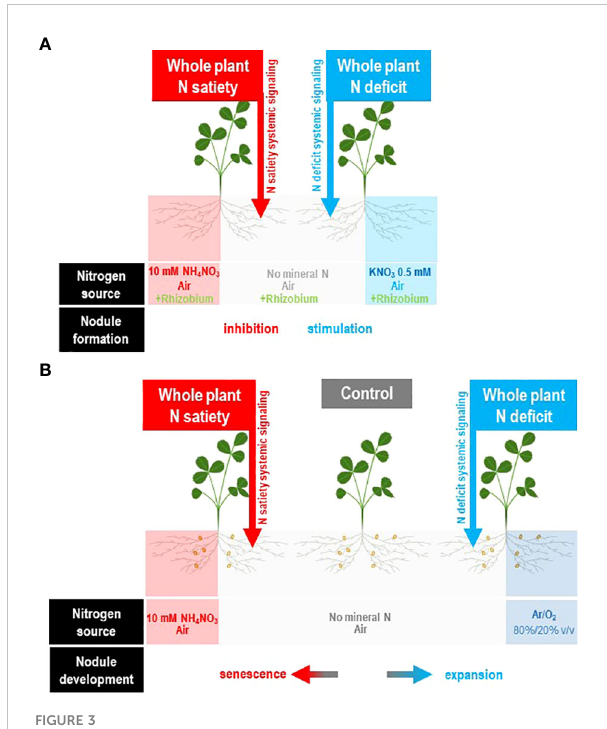
FIGURE 3 Split-root systems to characterize the control of nitrogen- fi xing symbiosis by systemic N signaling of the plant N demand. The experimental systems are described in the original studies of Ruffel et al. (2008); Jeudy et al. (2010); Laguerre et al. (2012); Lambert et al. (2020), and Pervent et al. (2021). M. truncatula plants are cultivated hydroponically. The root system of each plant is separated into two compartments. Each compartment receives speci fi c N supplies: either low level of mineral N supply (0.5 mM KNO 3 ), high level of mineral N supply, air (N 2 /O 2 80/20 v/v), or no gaseous N supply (Ar/O 2 80/20 v/v). At the beginning of the experiment, a contrasted N supply is applied to a half-root system. The N treatment modi fi es the whole plant N status and the whole plant N demand without affecting the environment and the untreated half- root system. Response of the untreated roots to this treatment results necessarily from systemic signaling originated from the rest of plant to these roots. (A) Split root systems used to study the control of nodule formation by plant N demand (Pervent et al., 2021). Non symbiotic plants are used. Contrasted mineral N supply applied to half-root systems may either fully satisfy the plant N demand (N satiety) or results in plant N limitation (N de fi cit). The response to inoculation by rhizobium in untreated roots strongly relies on the level of N supply of the plant revealing the strong systemic control of nodule formation by systemic signaling of the plant N demand. (B) Split root systems used to study the control of mature nodules by the plant N demand (Jeudy et al., 2010; Laguerre et al., 2012; Lambert et al., 2020). Symbiotic plants supplied with air as a unique N source through the function of mature N 2 fi xing nodules are used. N treatment applied to a half-root system may either fully satisfy the plant N demand (N satiety) or result in plant N limitation (N de fi cit). Plant N satiety resulted in nodule senescence whereas plant N limitation stimulates the expansion of mature nodules. The development of the nodules in untreated roots is strongly dependent on the level of supply of the whole plant, revealing the control by the systemic signaling of the whole plant N